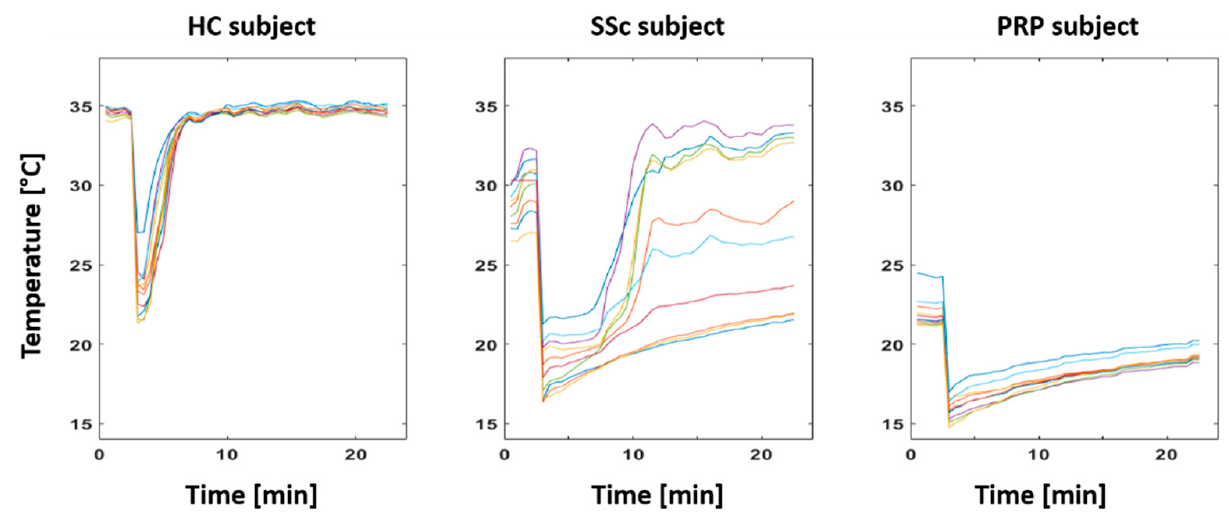
Figure 6. Time courses of the 10 fingers’ thermal recovery after the cold challenge in healthy control (HC), systemic sclerosis (SSc), and primary Raynaud’s phenomenon (PRP) representative par ‐ ticipants.